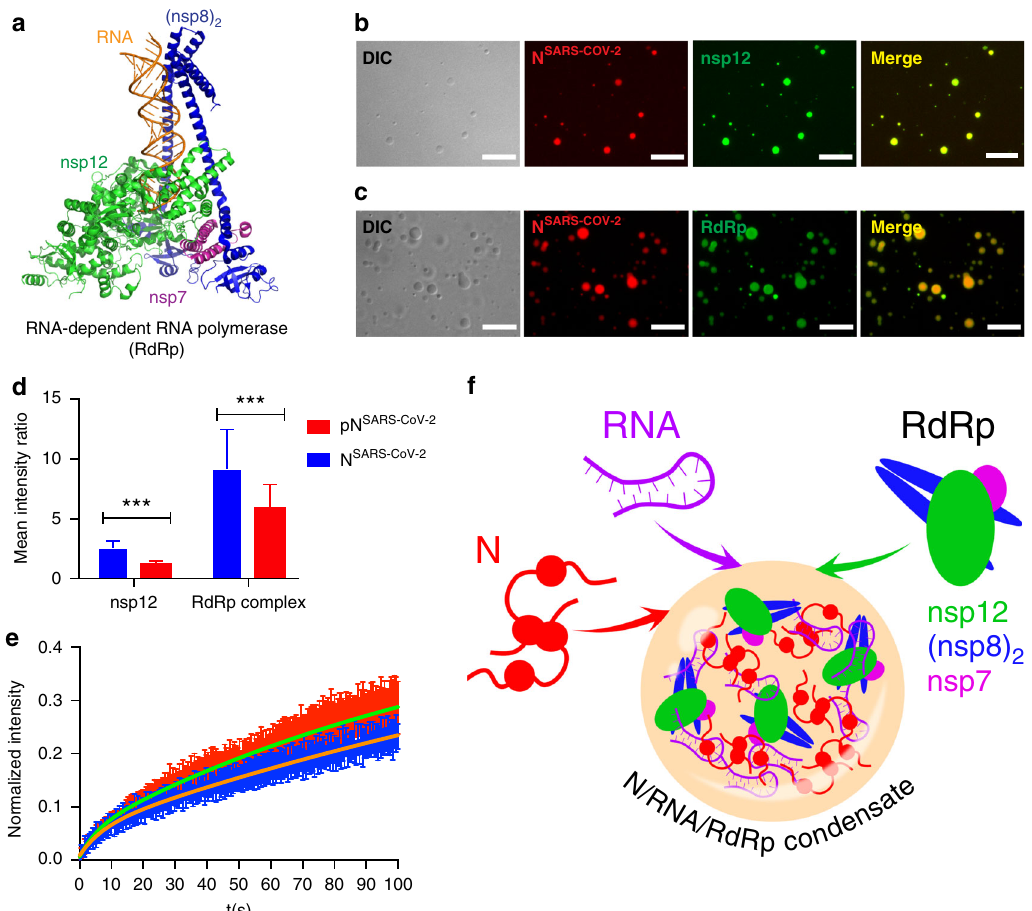
Fig. 5 The RNA-dependent RNA polymerase complex of SARS-CoV-2 concentrates in RNA/nucleocapsid protein-droplets. a Structure of the RNA- bound RdRp-complex formed by the SARS-CoV-2 non-structural proteins nsp12 (green), nsp7 (magenta) and nsp8 (blue) in 1:1:2 stoichiometry (PDB code: 6YYT) 29 . b Fluorescence and DIC microscopy show the recruitment of Alexa Fluor 488 labeled nsp12 (green), the catalytic subunit of the RdRp-complex, into N SARS-CoV-2 /polyU droplets (N SARS-CoV-2 in red). c Active SARS-CoV-2 RdRp-complex bound to a fl uorescein-labeled minimal RNA hairpin concentrates inside of N SARS-CoV-2 /polyU droplets. In ( b ) and ( c ) droplets of 50 µ M N SARS-CoV-2 and 1 µ M polyU were prepared in 20 mM NaPi, pH 7.5, and visualized by the addition of a small amount of Alexa Fluor 594 labeled N SARS-CoV-2 protein. Scale bars are 10 µ m in ( b ) and ( c ). Micrographs are representative of three independent biological replicates. d Recruitment of nsp12 and RdRp complex into polyU-induced droplets of unmodi fi ed (blue) and SRPK1-phosphorylated (red) N SARS-CoV-2 . Mean values and standard deviation are shown ( n = 100 droplets). Two-sided t-test with P value set to < 0.05 for statistical signi fi cance, ***<0.001, **<0.002 and *<0.033, ns < 0.12. e FRAP of nsp12 after recruitment into N SARS-CoV-2 /polyU (blue) and SRPK1- phosphorylated N SARS-CoV-2 /polyU (red) droplets. Error bars represent the standard deviation for averaged 10 and 11 curves for unmodi fi ed and phosphorylated N SARS-CoV-2 , respectively. ( f ) Schematic representation of the LLPS-based formation of N/RNA/RdRp-condensates as protein/RNA-dense sites for viral from GenScript and ThermoFisher, respectively. The SR peptide, comprising residues 182-197 of the nucleocapsid protein of SARS-CoV-2, was produced by nuclei 32,33 to enable high initiation and elongation rates during Fmoc-solid-phase synthesis using an automated microwave peptide synthesizer viral transcription. Because the replication machinery of cor- (Liberty 1, CEM) with acetyl ‐ and amide protection groups at the N ‐ and C ‐ onaviruses is membrane-associated 34 , it will furthermore be termini, respectively, and further puri fi ed by reverse-phase high-performance interesting to investigate if the SARS-CoV-2 glycoprotein M, liquid chromatography (LC). Peptide masses were determined by LC-MS using an Acquity Arc System (WATERS) with SQD2-mass-detector. which binds nucleocapsid protein 4 , causes tethering of N SARS- CoV-2 /RdRp/RNA-condensates to host cell membranes. Taken together the data suggest that inhibition of the RNA- induced phase separation of the nucleocapsid protein of SARS- CoV-2 provides a viable and novel strategy for the design of therapeutics to treat Covid-19.